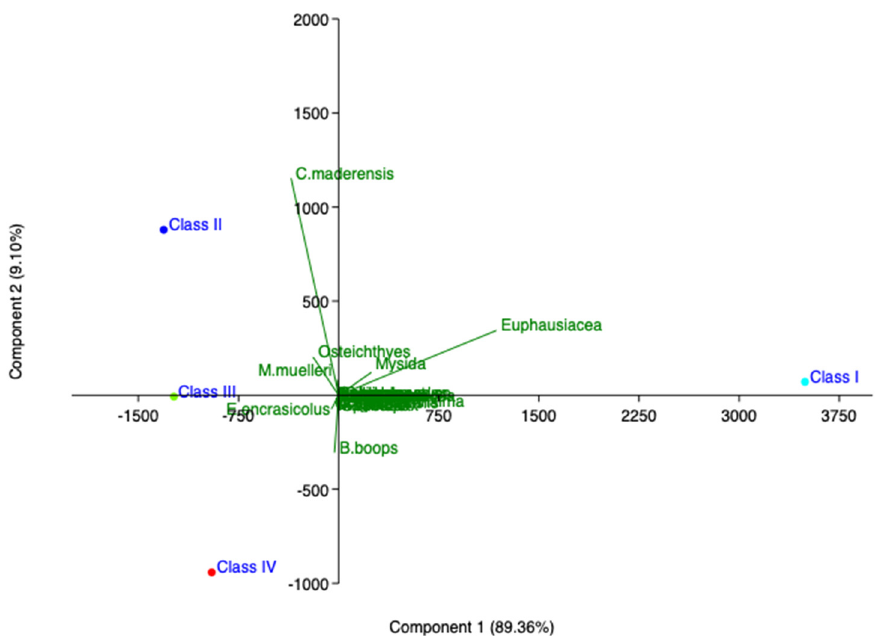
Figure 4. Principal component analysis (PCA) of hake diet in southern and central Tyrrhenian Sea (2018).